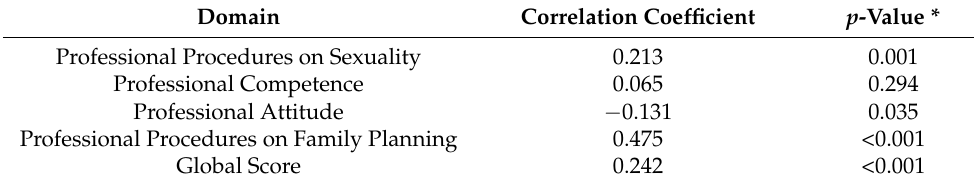
Table 11. Scores regarding the age of the participants.